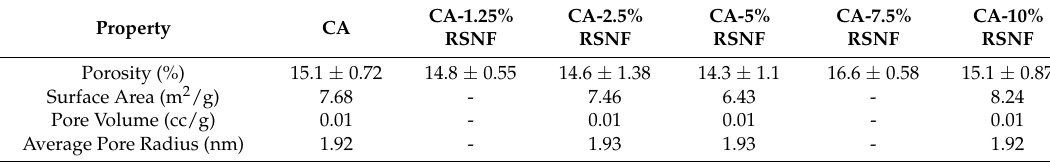
Table 2. Porosity and surface area characteristics of CA and CA/RSNF films.